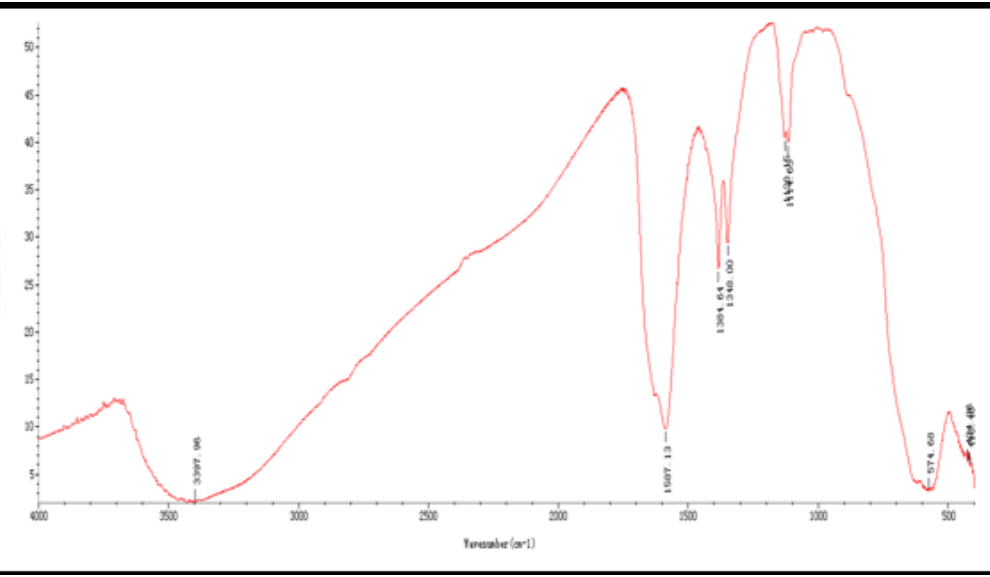
Fig.2. FTIR of magnetic Nanoadsorbent showing different I.R